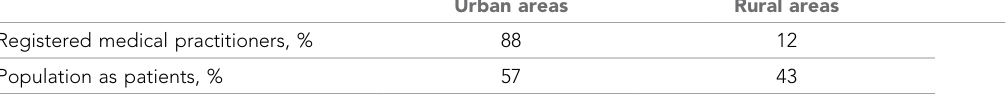
Table 2. Distribution of healthcare workers and patients across urban and rural regions